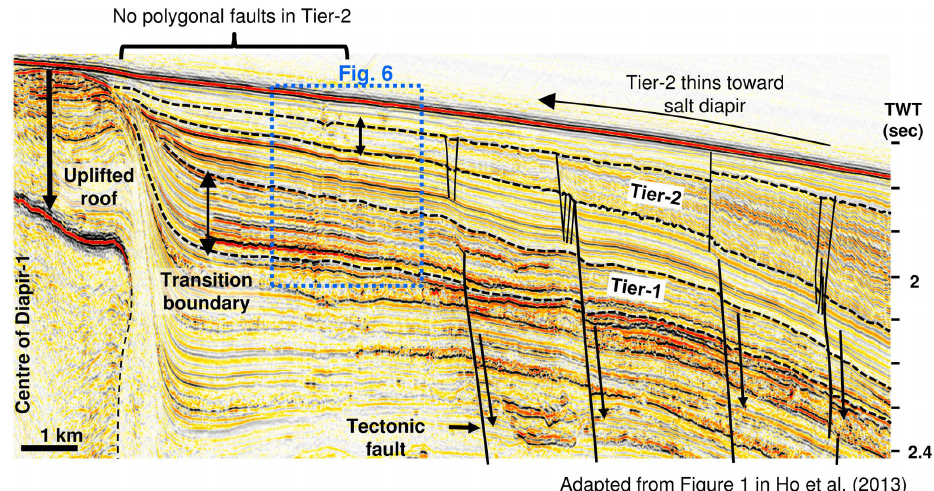
Figure 3. Arbitrary seismic line showing the pinch-out of polygonal fault tiers (defined by black dotted lines) against the SE flank of Diapir-1. Line location is shown in Fig. 1. The polygonal faults disappear beyond the black vertical arrows, progressively towards the pinch-out of the tier at the transitional boundary where the wedge thickness starts to be less than 60msTWT. Note that PFs are absent toward the pinch-out of Tier-2, but are present at the same location in Tier-1 below where this tier reaches its maximum thickness (Ho et al., 2013). This may provide additional support for the theory of minimum thickness determining PF growth (Carruthers, 2012). This observation can serve as a reference example for PF growth. Image adapted from Ho et al. (2013).